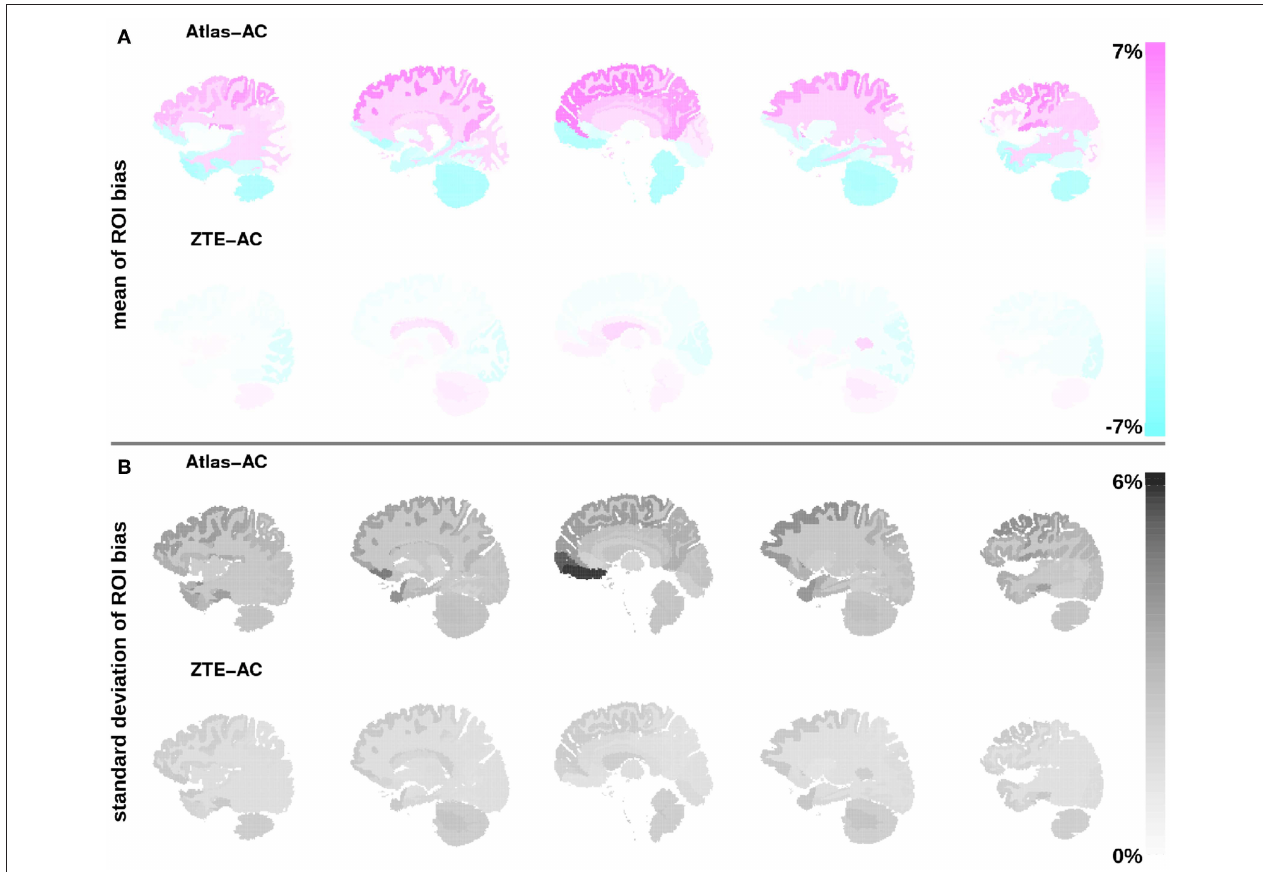
FIGURE 4 | (A) Mean of bias in the PET reconstruction in all 85 anatomical VOIs averaged over all 30 static PET acquisitions for Atlas-AC (top row) and ZTE-AC (bottom row). (B) Standard deviation of VOI bias. The VOI location is visualized in five sagittal slices using the brain anatomy of subject 1. Please note that the VOIs in the cerebellum had to be excluded in three subjects (6, 7,